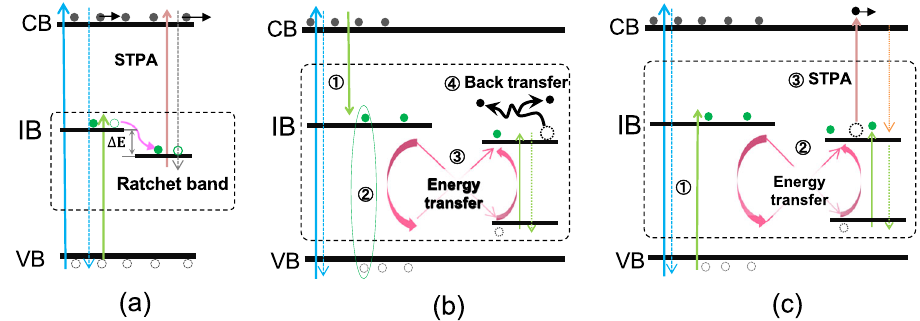
Fig. 1 Operation schemes of different types of intermediate-band solar cells (IBSCs) and the energy-transfer model. a Conventional ratchet IBSC involving carrier excitation, recombination, and sequential two-photon absorption (STPA) among the valence band (VB), intermediate band (IB), conduction band (CB), and ratchet band located at an energy Δ E below the IB, b energy-transfer and back transfer model, and c the energy-transfer- coupled ratchet IBSC along with proposed in this work,